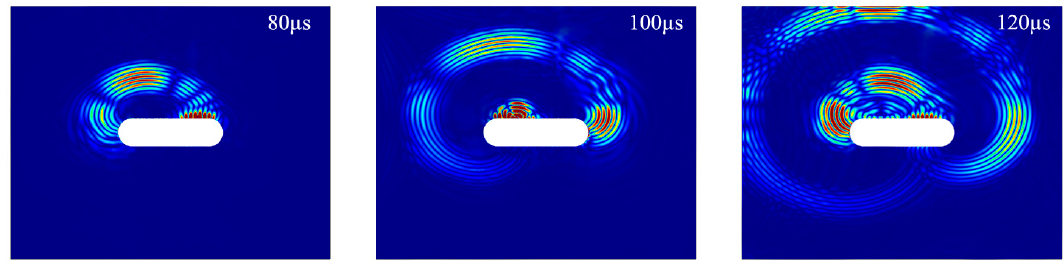
Figure 13. Snapshot of the FE scattered wave field in the angular component due to the presence of a hidden crack.